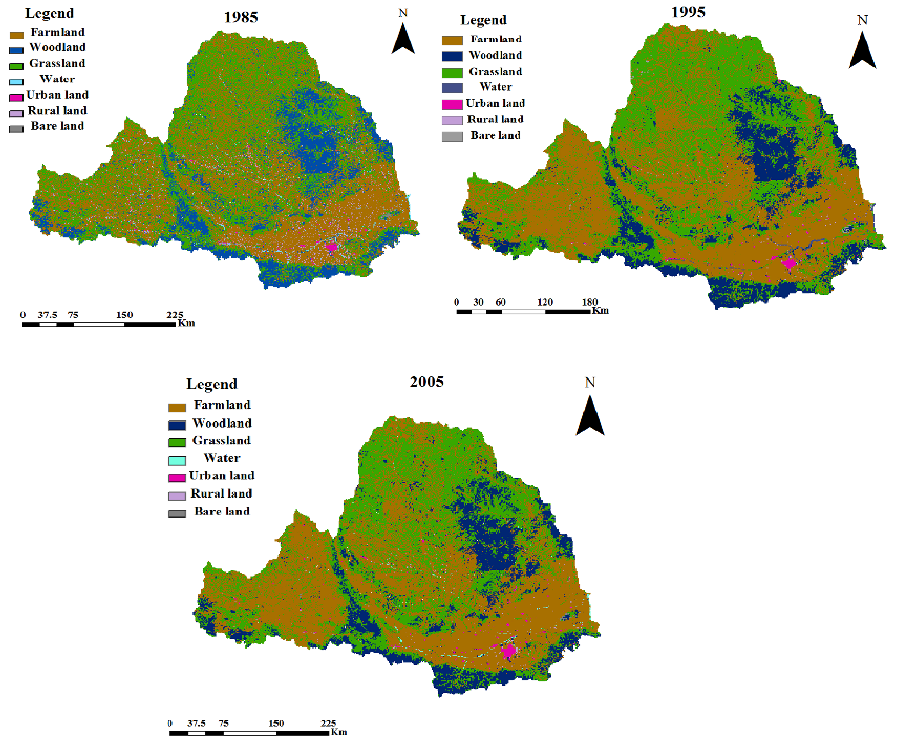
Figure 3. Three land cover maps of the Wei River Basin.